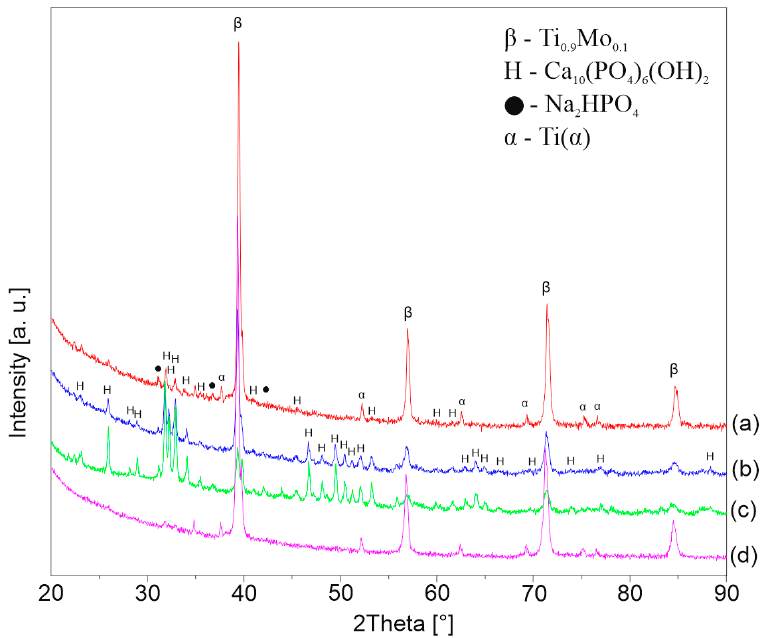
Figure 12. XRD patterns of ( a ) 35-5HT, ( b ) 35-7HT, ( c ) 35-10HT, ( d ) 35-12HT.